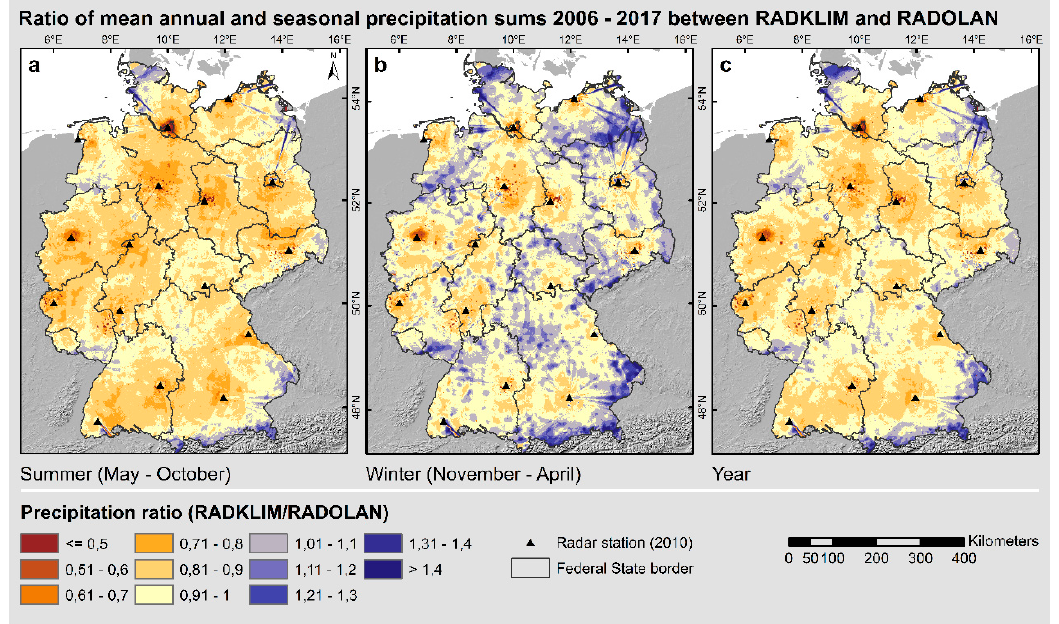
Figure 6. Ratio of mean annual and seasonal precipitation sums 2006–2017 between RADKLIM and RADOLAN.